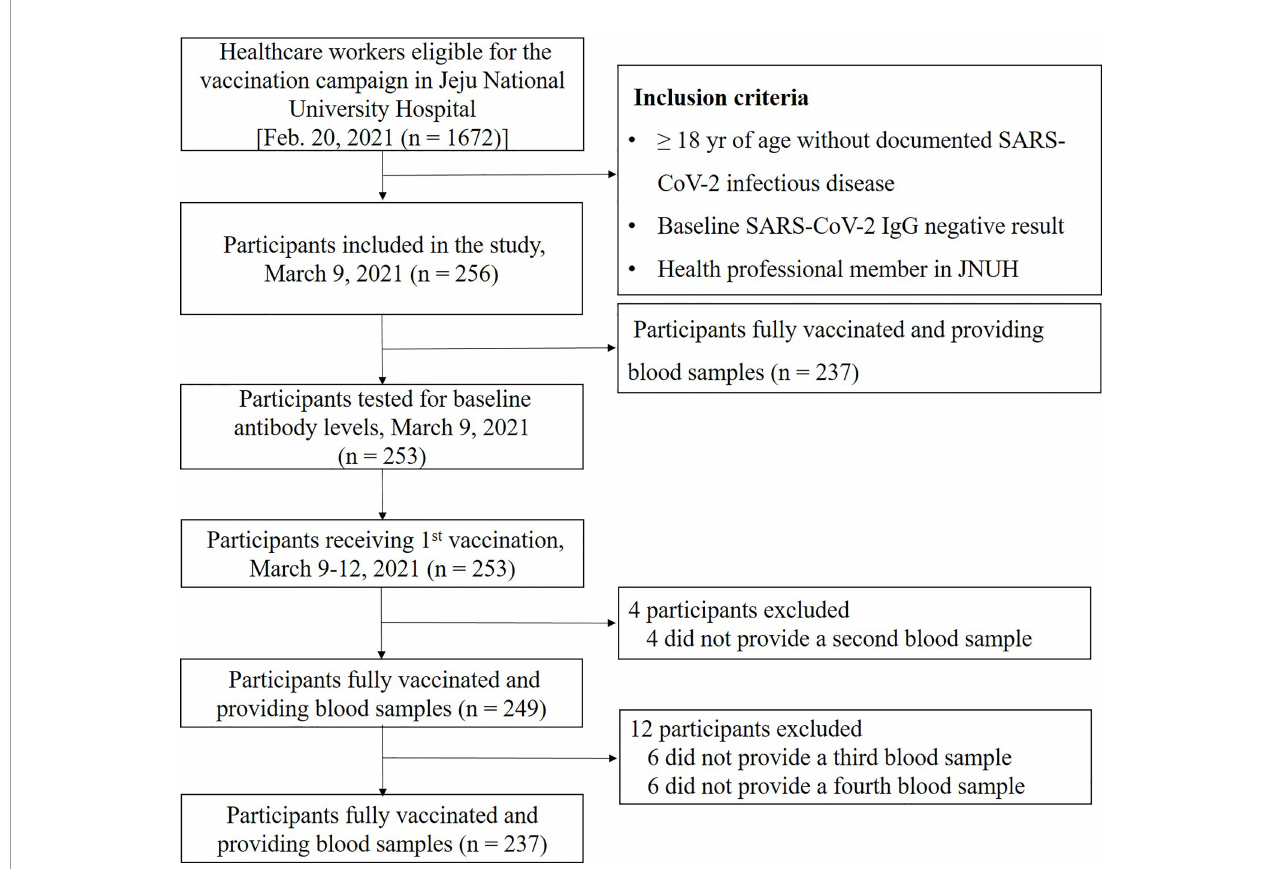
FIGURE 1 | Enrollment and fl ow of study. This diagram represents all available enrolled participants. Analysis of antibody was performed in 249 subjects who were completed the full vaccination and provided blood